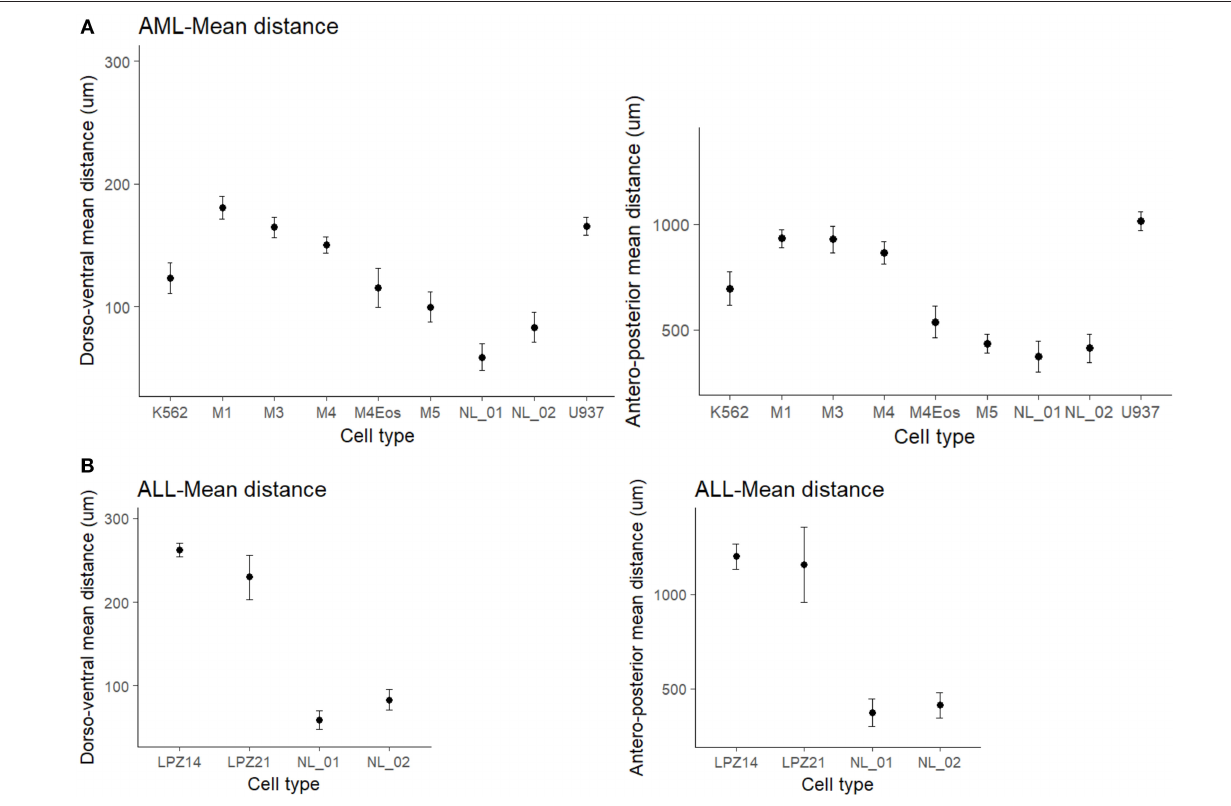
FIGURE 3 | Mean migration distances of xenografted cells into zebrafish embryos at 1 dpi. (A) Differences of mean migration between myeloid leukemic and non-leukemic human cells toward the antero-posterior and dorso-ventral axis. (B) Differences of mean migration between lymphoid leukemic and non-leukemic human cells. Non-overlapping confidence intervals mean statistical significance. The comparison was established according to morphological and immunophenotypic similarities between samples from the same subtype based on FAB scheme. Migration differences were established based on a standard-deviational ellipse with 9999 permutations. NL, Non-leukemic